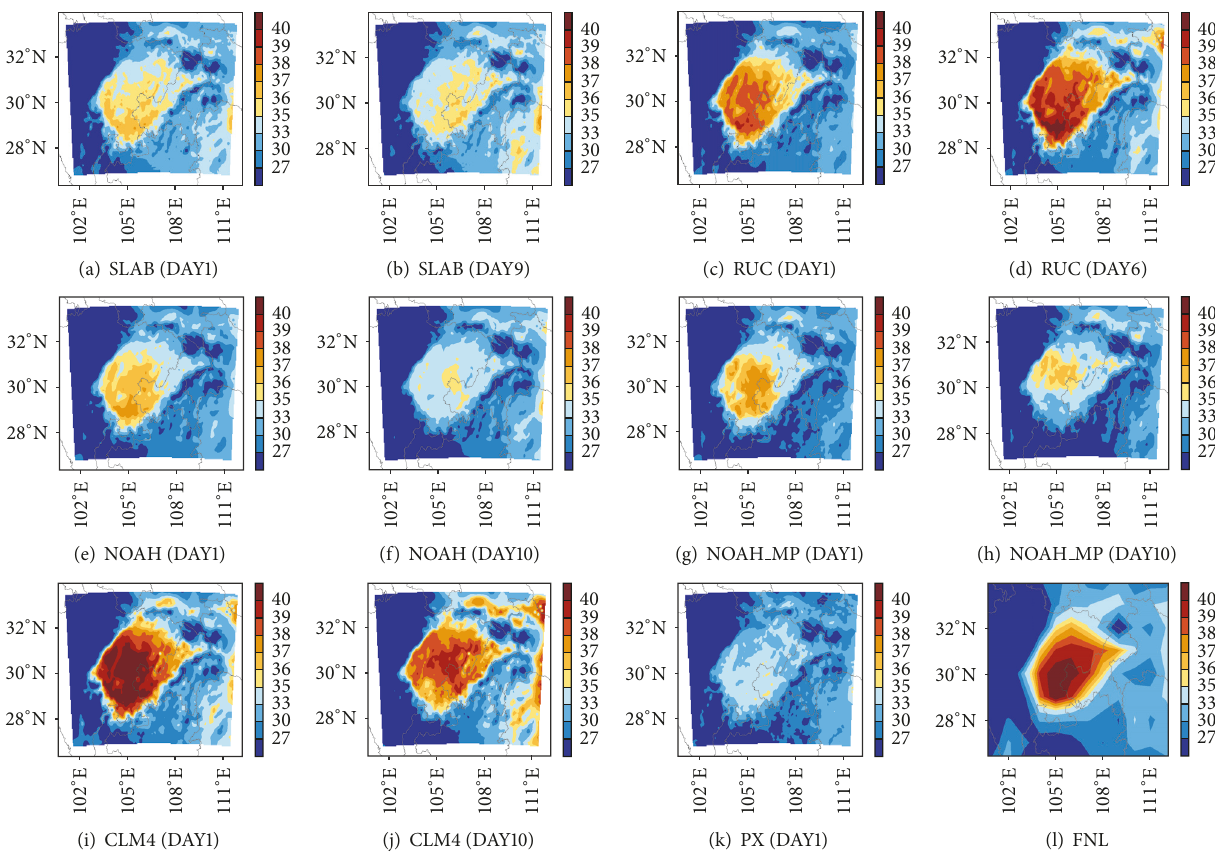
Figure 2: Distributions of SAT06 (unit: ∘ C) on August 10, 2006, were (a) SLAB (DAY1), (b) SLAB (DAY9), (c) RUC (DAY1), (d) RUC (DAY6), (e) NOAH (DAY1), (f) NOAH (DAY10), (g) NOAH MP (DAY1), (h) NOAH MP (DAY10), (i) CLM4 (DAY1), (j) CLM4 (DAY10), (k) PX (DAY1), and (l)